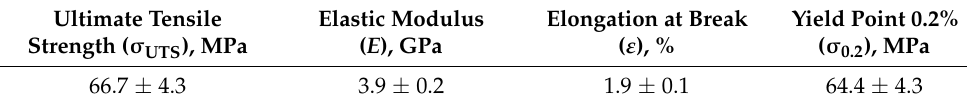
Table 8. The mechanical properties of the USW lap joint obtained with mode